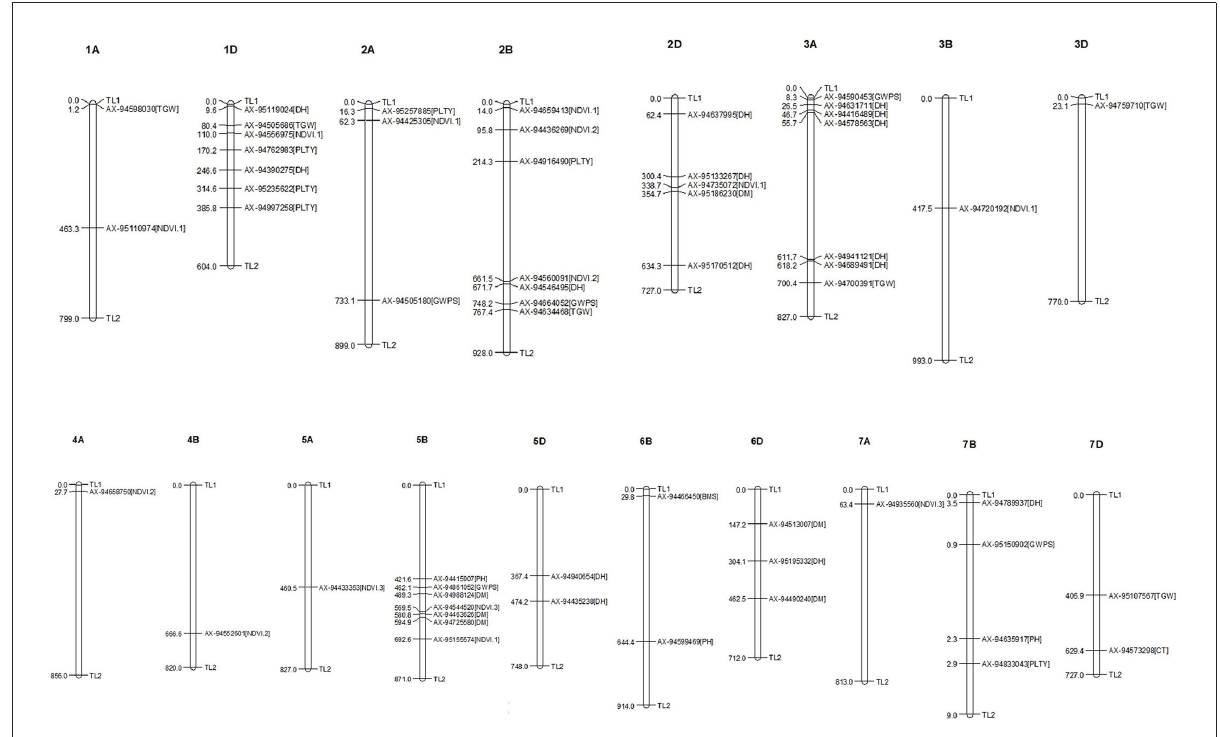
FIGURE6 Distribution and position of identified MTAs ( -log(p) above 5.32) at their respective